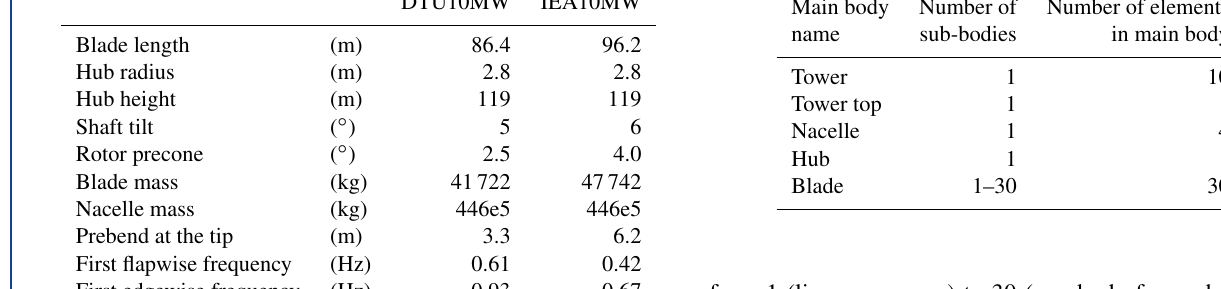
from 1 (linear response) to 30 (one body for each element, equivalent to a corotational approach). The rest of the tur- bine model was kept the same for a coherent comparison. The HAWC2 models of the considered turbines for this publica- tion are composed of nine main bodies: tower, tower top, na- celle, three hubs and three blades. Table 2 shows the number of sub-bodies in the turbine models and the number of beam elements in each body. The tower, tower top, nacelle and hubs are modeled via one sub-body; in other words they are modeled as linear structures. Blades are the only parts which are modeled by multiple sub-bodies to capture large deflec- tions. Both turbine models have 50 aerodynamic sections (or calculation points) on each blade, and the open-source Basic DTU Wind Energy controller (Hansen and Henriksen, 2013) was used. The turbulence boxes were generated by the Mann turbulence generator (Mann, 1994). A constant time step of 0.01 s was used for all considered cases. The computational time was recorded for all cases, and both the sparse and dense matrix solvers were considered. The number of bodies in the model alters the problem size since it changes the number of generalized coordinates and constraints in the equations. The number of generalized coordinates and constraint equations can be determined by Eqs. (5)–(6). In the equations, N mb is the number of main bodies, and N i and N i are the number of elements and el sb sub-bodies in the i th main body. The number of bodies in each blade model varies from 1 to 30. The 30-sub-body blade model (similar to the corotational model) is the most accurate with the highest N and N c , whereas the one sub-body blade case is the linear blade case. Table 2 shows the element num- bers at each main body in the turbine models. In all cases, the blades dominate the problem sizes. For example, in the one- body case the blades have 558 generalized coordinates and 18 constraint equations. For the 30-sub-body case, the three blades have 1080 generalized coordinates and 540 constraint equations. Although the problem size in the FRF formulation changes with the number of bodies defined in the model, the number of independent coordinates ( N − N c ) is always 648 for this turbine